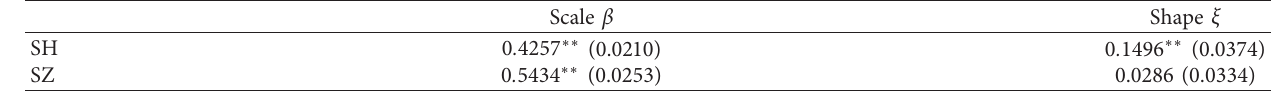
Table 2: Estimation results for generalized Pareto distribution.